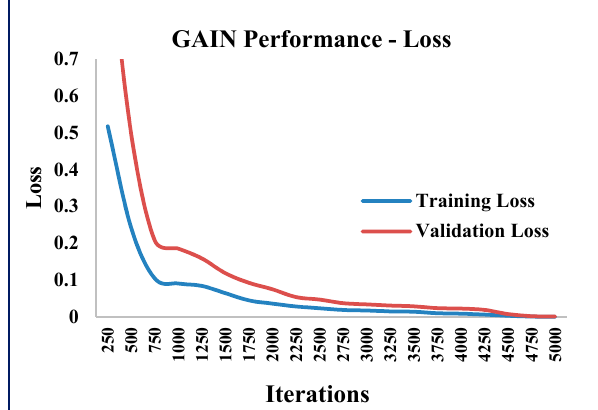
Figure 13. GAIN loss measure.